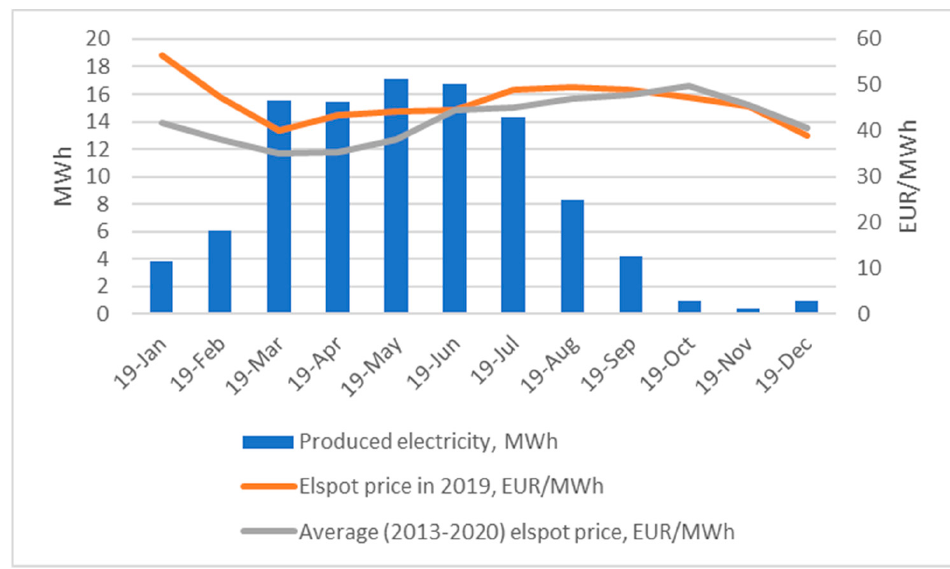
Figure 5. Real PV system electricity production versus dynamic electricity price.